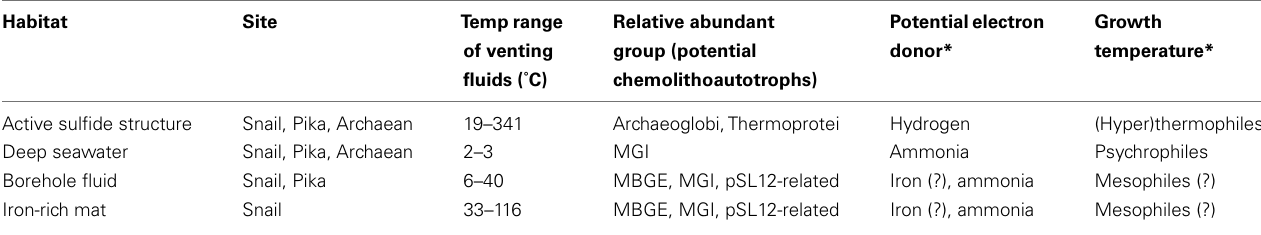
Table 2 |Abundant taxonomic groups in the archaeal clone libraries for each